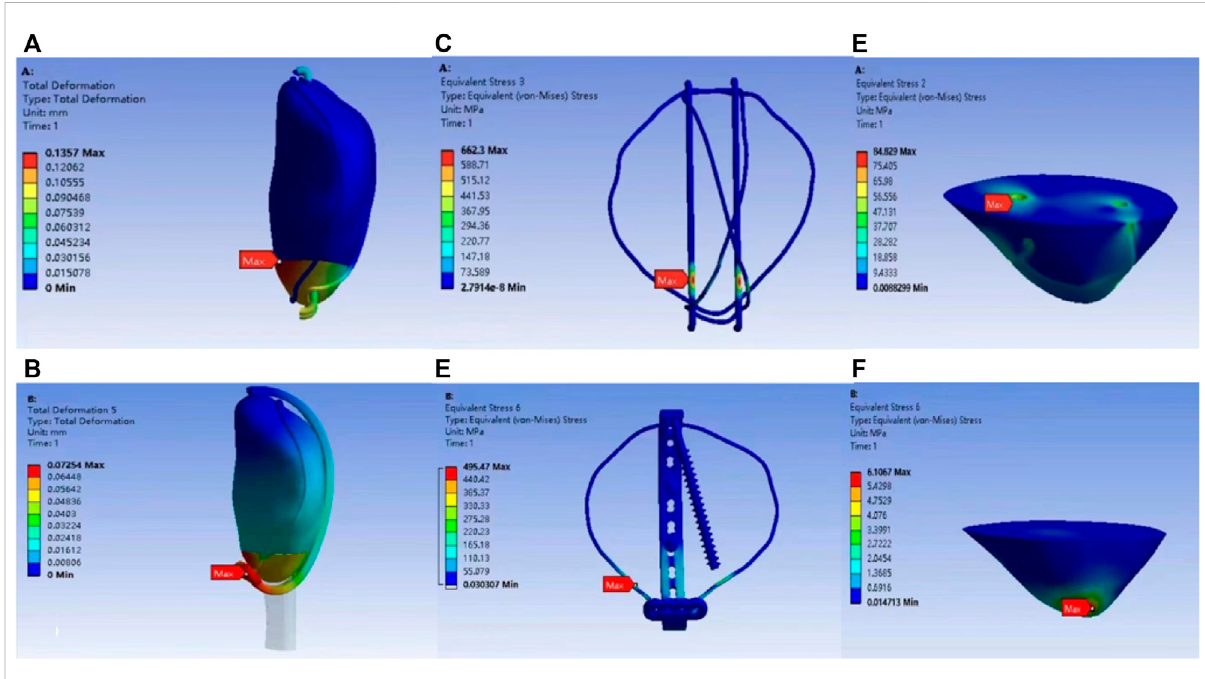
FIGURE 4 Model displacement distribution program of K-wire group (A) and ALP group (B) . K-wire group (C) and ALP group (D) model internal fi xation stress distribution program. Stress distribution program of the polar bone block under K-wire group (E) and ALP group (F) models.